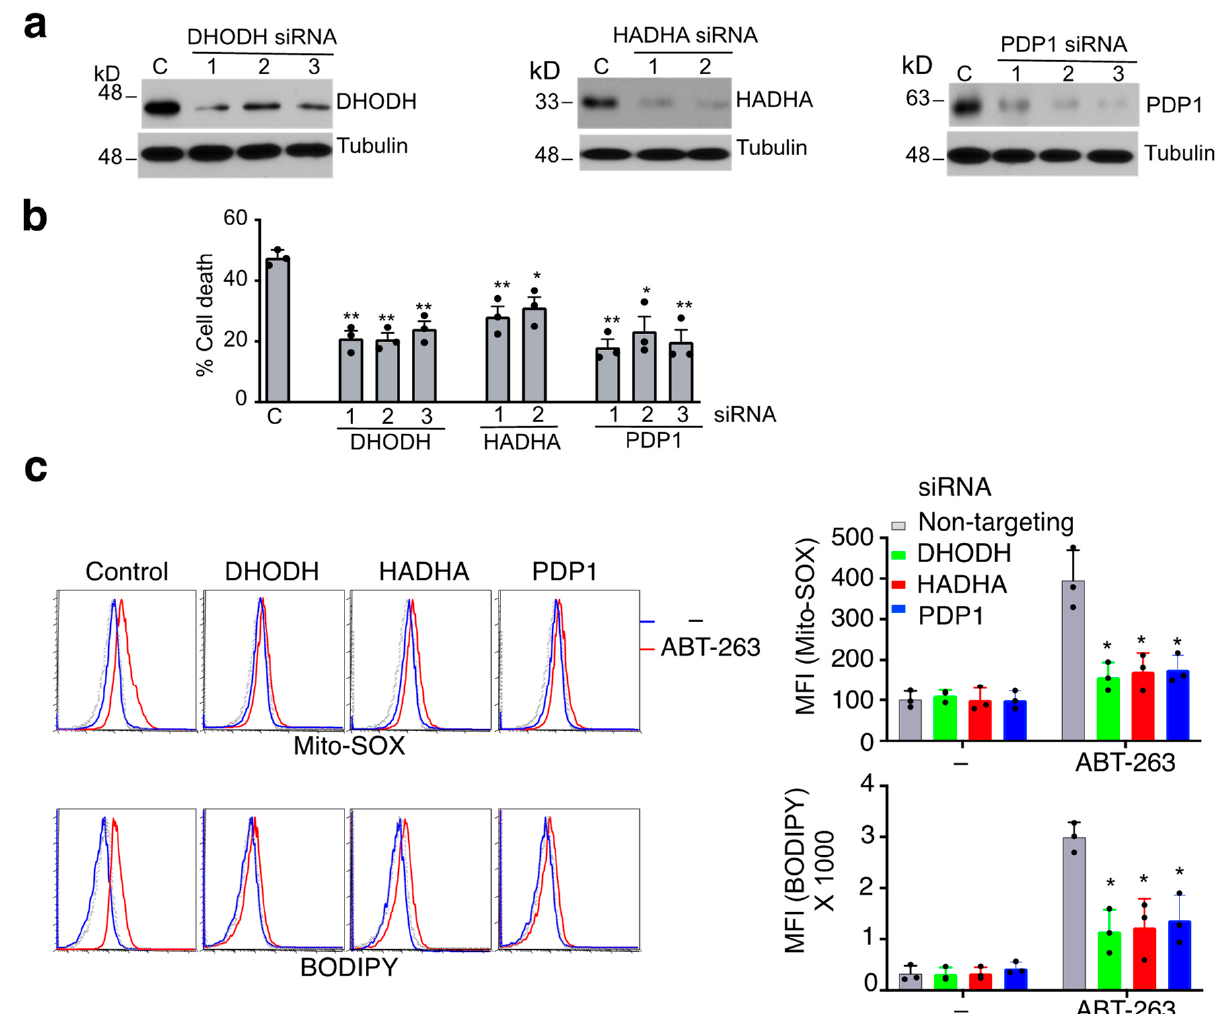
Figure 3. Genes involved in ROS and caspase-9-independent cell death. ( a ) JMR cells transfected with individual siRNA targeting different genes or non-targeting control (C), followed by Western blot analyses. ( b ) The cells were treated with ABT-263, followed by quantitation of cell death. ( c ) Cells transfected as in ( a ) were cultured with or without ABT-263. The cells were stained with Mito-SOX to measure ROS, or with BODIPY 481/581 C11 to measure lipid peroxidation, and analyzed by flow cytometry. Dashed line: unstained control. Mean fluorescence intensity (MFI) of the staining is presented as mean ± SD. * p < 0.05, ** p < 0.01.